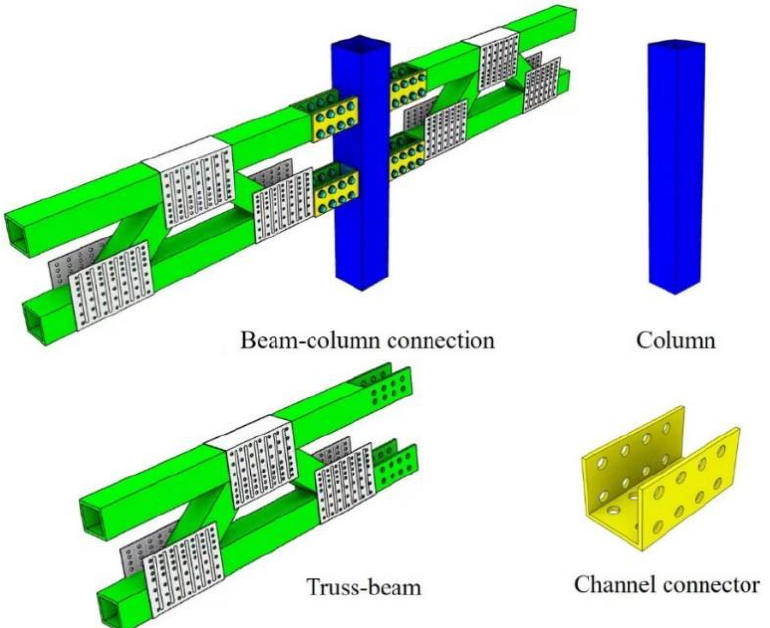
Figure 1. General composition of the cruciform light-steel beam – column connection.